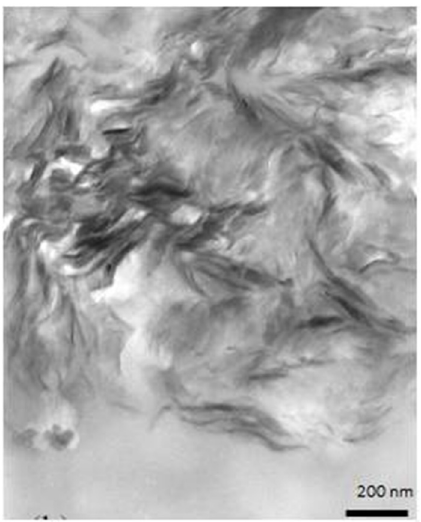
Figure 7: TEM image of organoclay/polymer nanocomposite. Reproduced from ref. [ 92 ] with